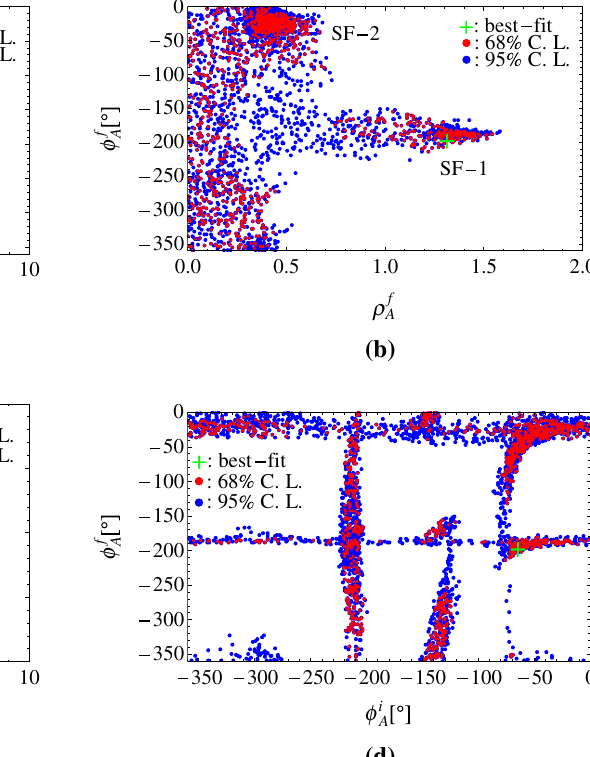
Fig. 2 The allowed spaces of (ρ i C.L. under the constraints from the measured ¯ B s → φ K ∗ 0 and φφ decays, namely, case I. The fitted spaces are also shown in (ρ i